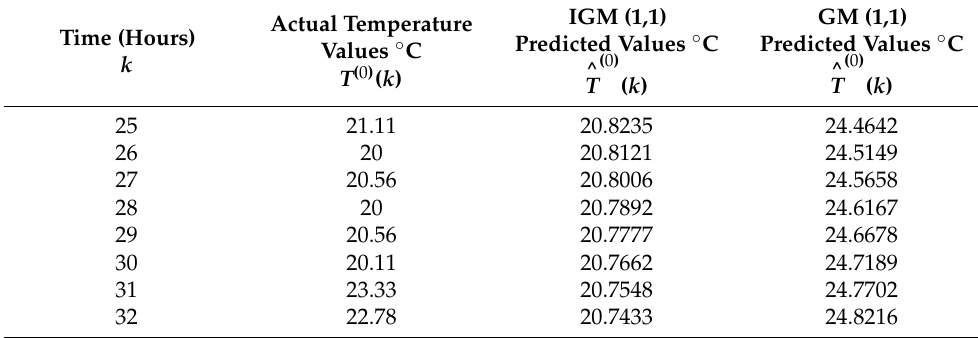
Table 3. Comparison of IGM (1,1) and GM (1,1) models’ predicted values for Oakland University’s GHPS output temperature prediction for the period from 25 to 32 h (Out-of-sample).